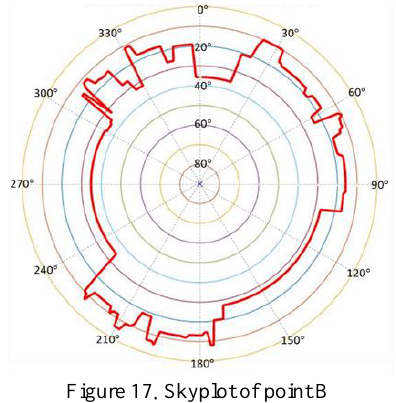
Figure 21. Skyplot of point A per the three different datasets